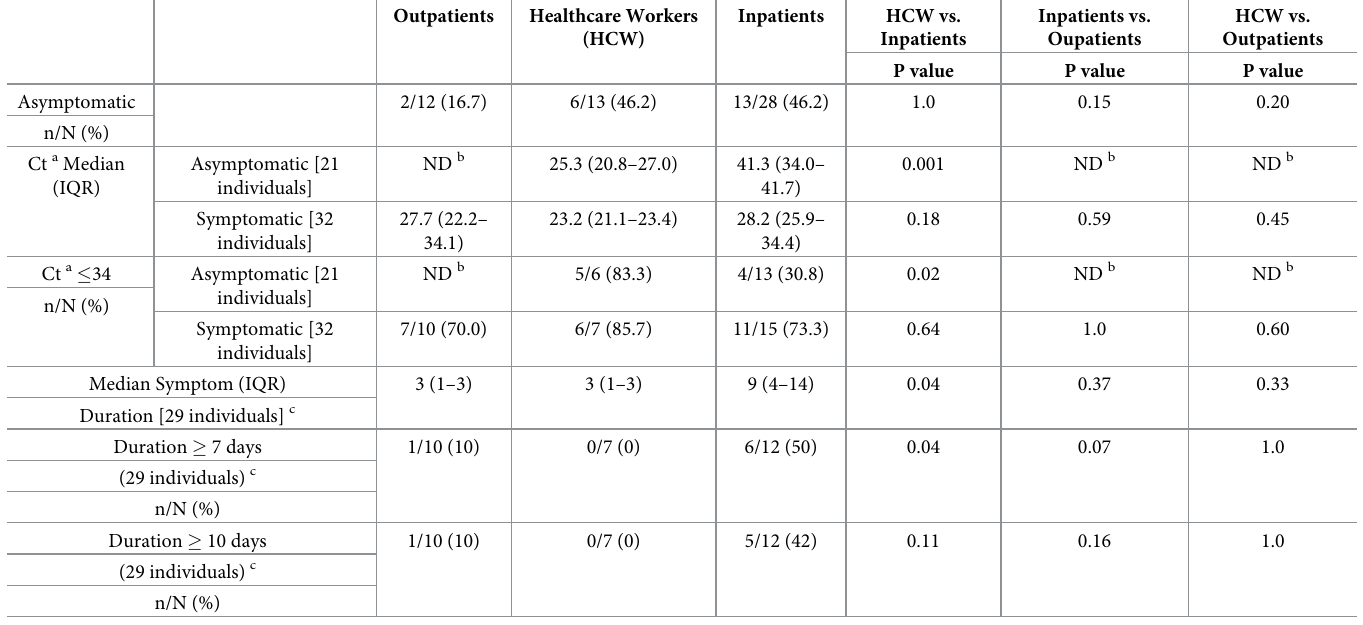
Table 2. Comparison of asymptomatic and symptomatic persons with a positive SARS-CoV-2